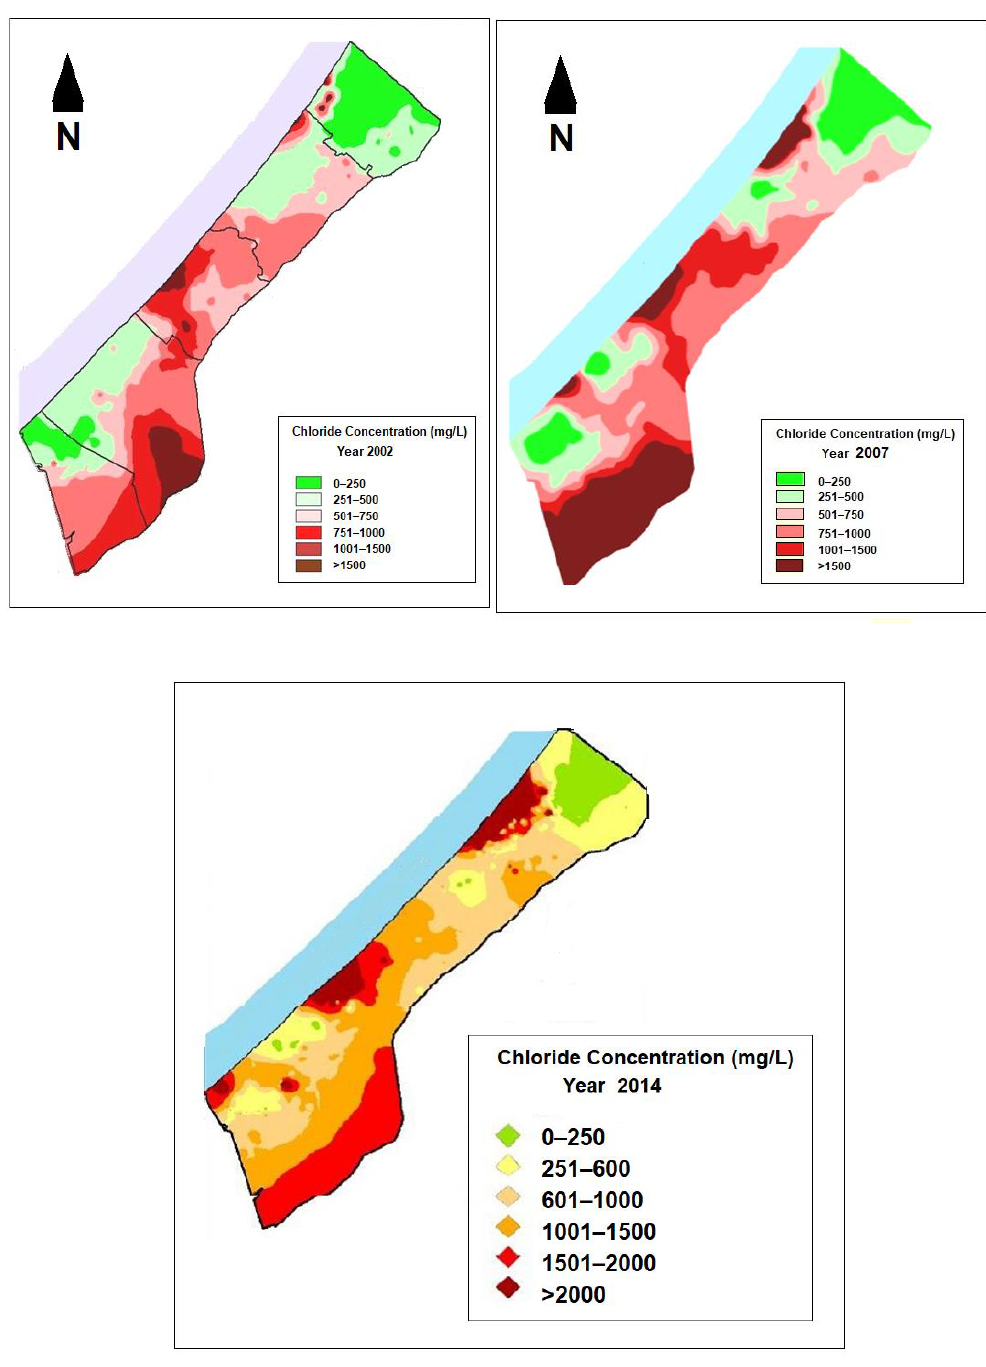
Figure 2. Average chloride concentration of pumped groundwater from GCA in 2002, 2007, and 2014 [18,29].